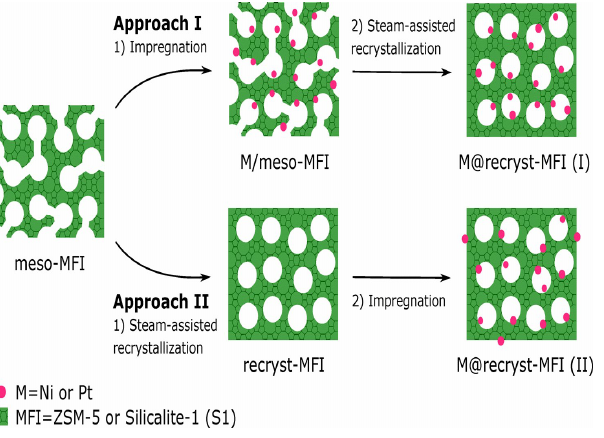
Figure 1. Metal nanoparticles encapsulated in MFI structure. Reproduced from [2]. Copyright ACS